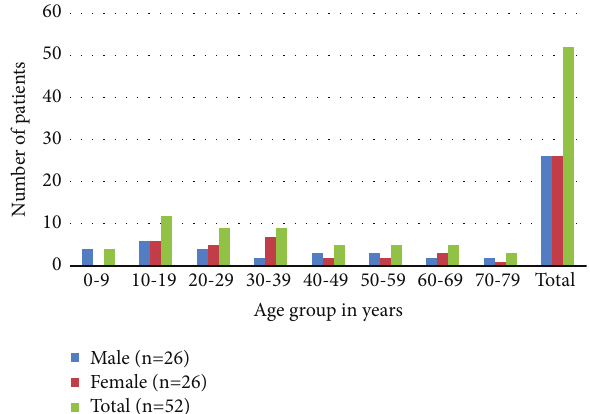
Figure 1: Demographic classification of gender based on different age groups.